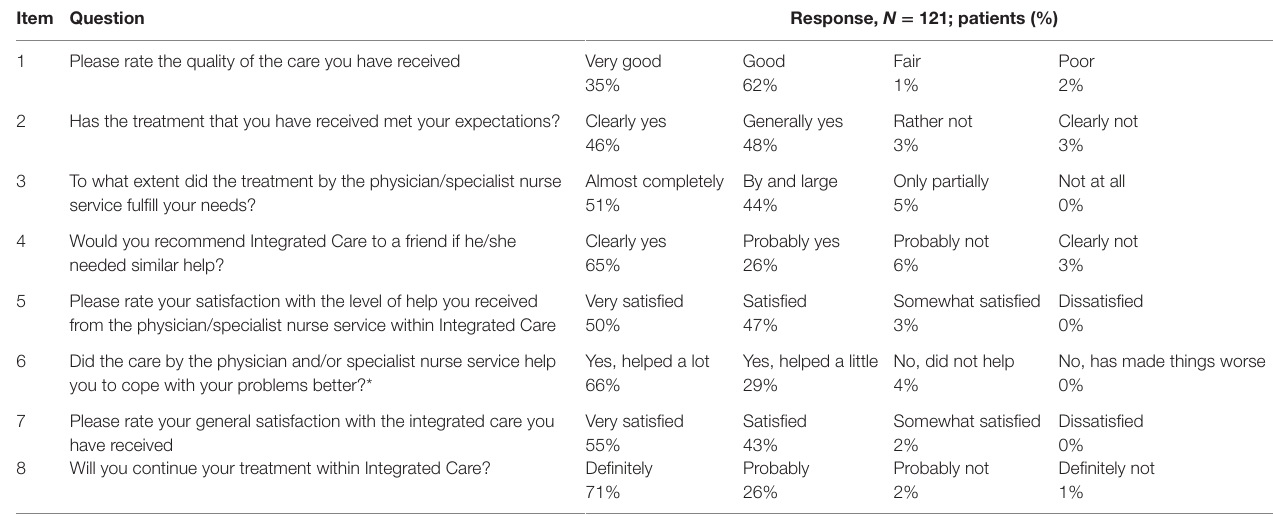
TaBle 1 | Patient responses to the eight items of the modified ZUF-8 questionnaire.